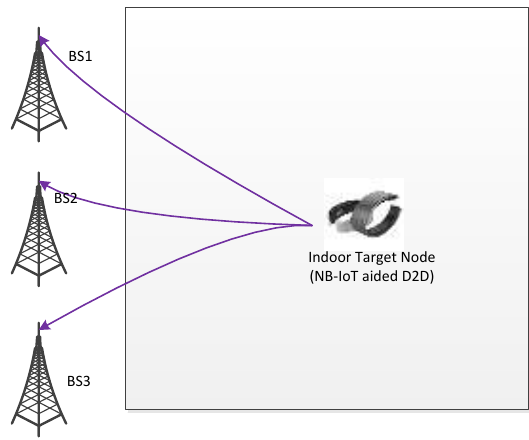
Figure.2 In the coverage area of only D2D relays